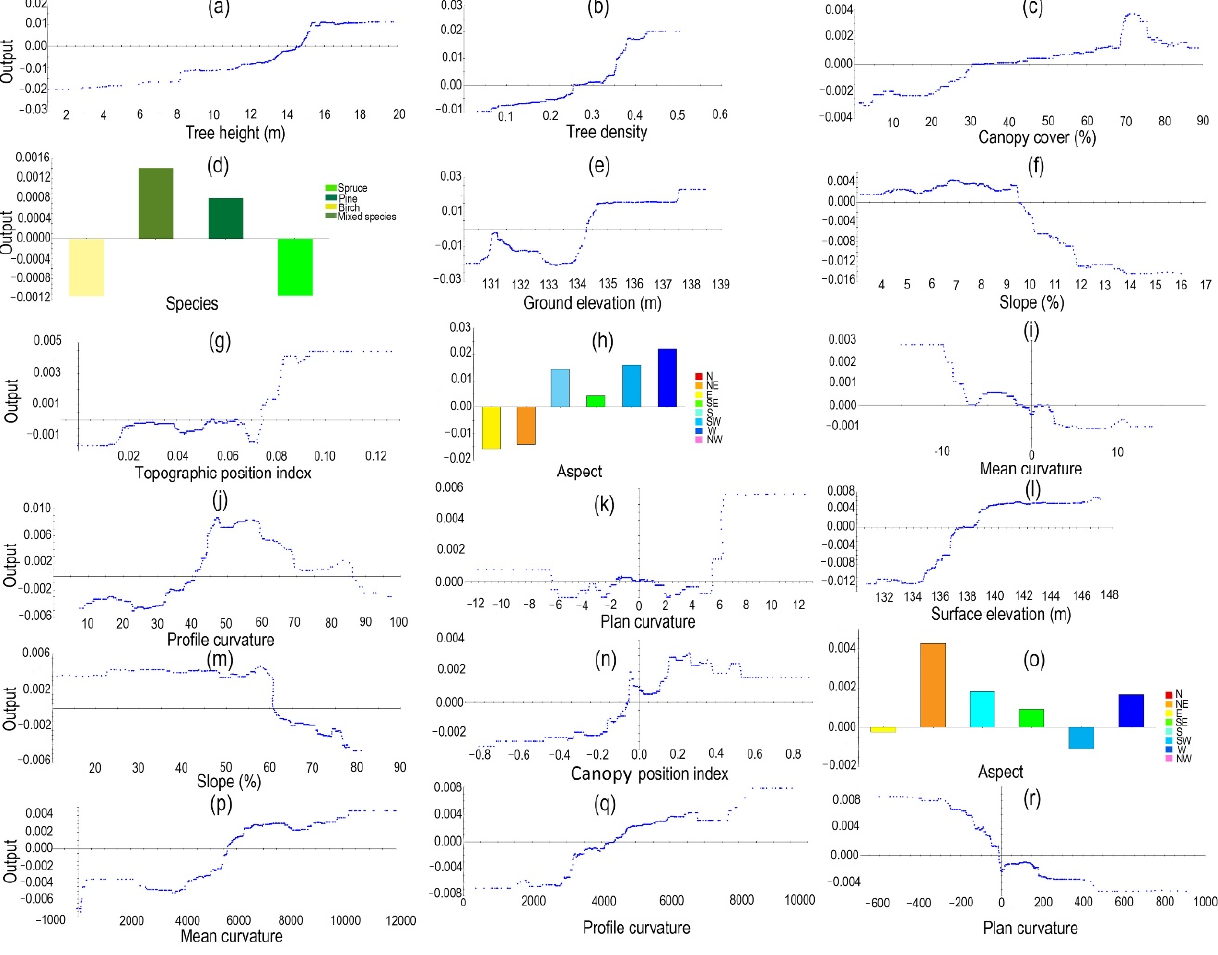
Figure 7. Univariate partial dependence plots for features affecting the positioning accuracy of the u-blox ZED-F9P. ( a – d ) tree characteristics, ( e – k ) topography conditions, and ( l – r ) canopy-surface conditions.